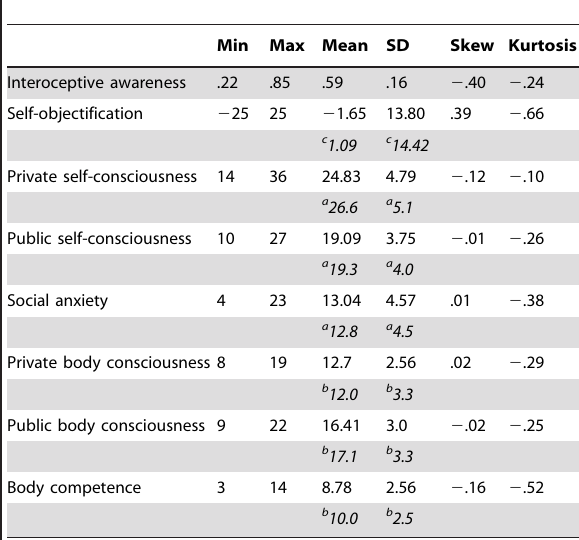
Table 1. Descriptive statistics for all